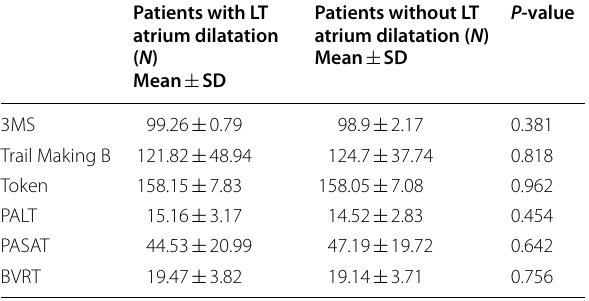
Table 3 Comparison between patients with and without diastolic dysfunction regarding cognitive function